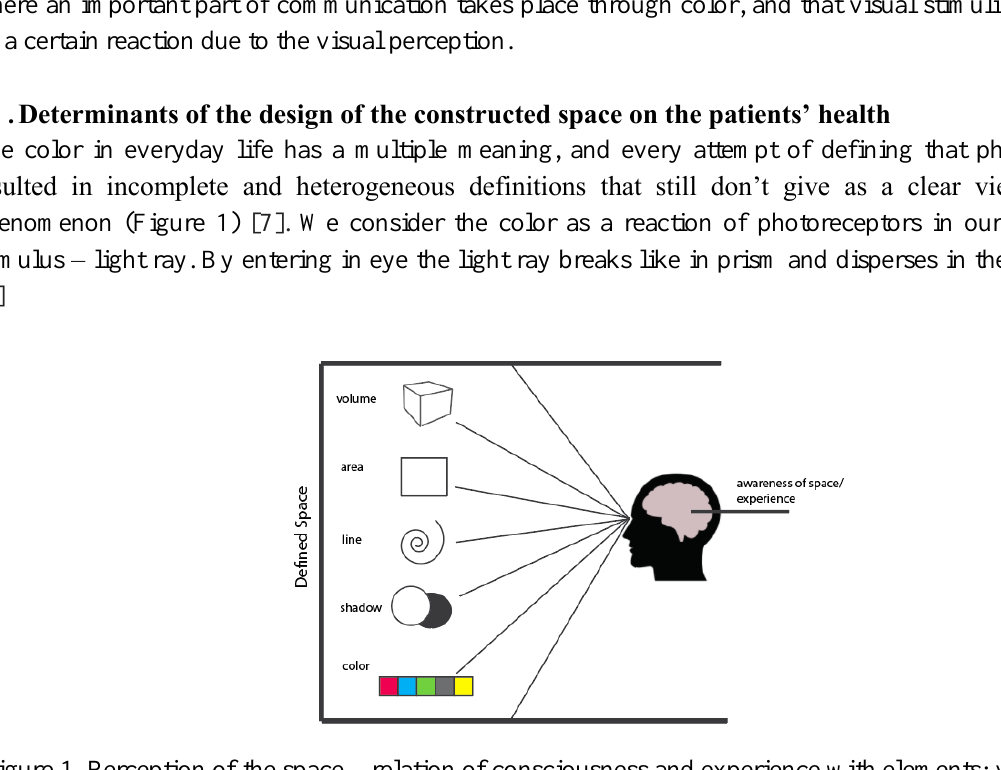
Figure 1. Perception of the space – relation of consciousness and experience with elements: volume, surface, lines, shadows and colors